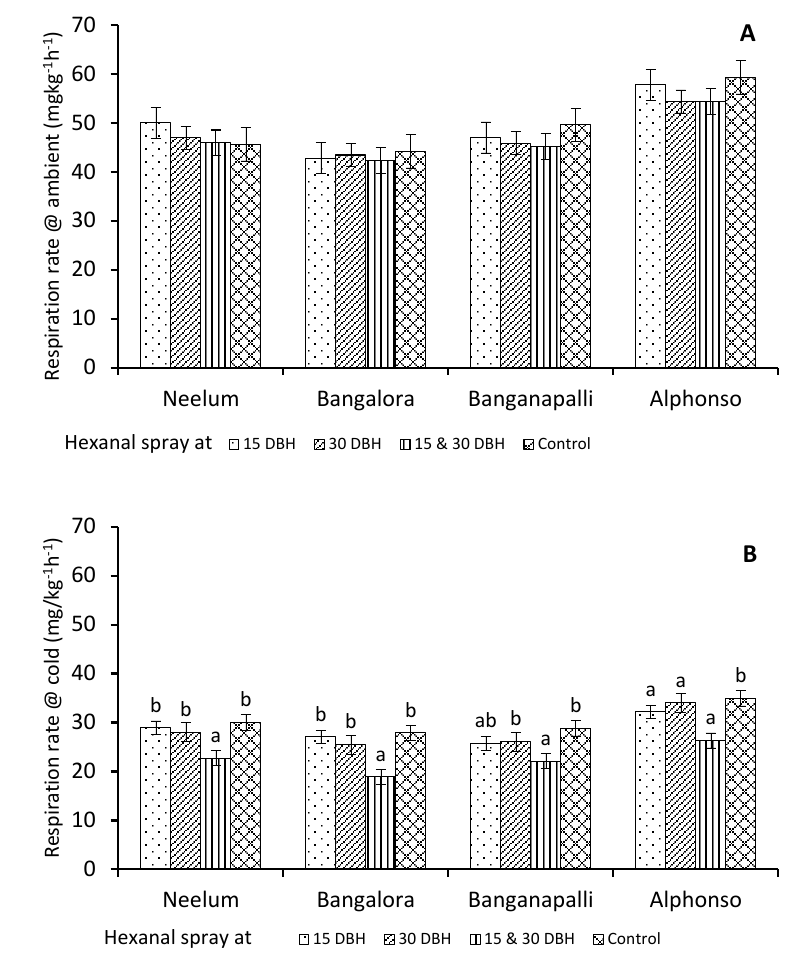
Figure 4. Mean respiration rate of the hexanal-treated and control mango fruit cultivars during the storage period in ambient ( A ) and cold ( B ) storage conditions. The vertical bars in the columns represent the standard error of four replicates (n = 15). Columns with different or the same letters indicate statistical significance and non-significance respectively ( p = 0.05). DBH—Days before harvest.